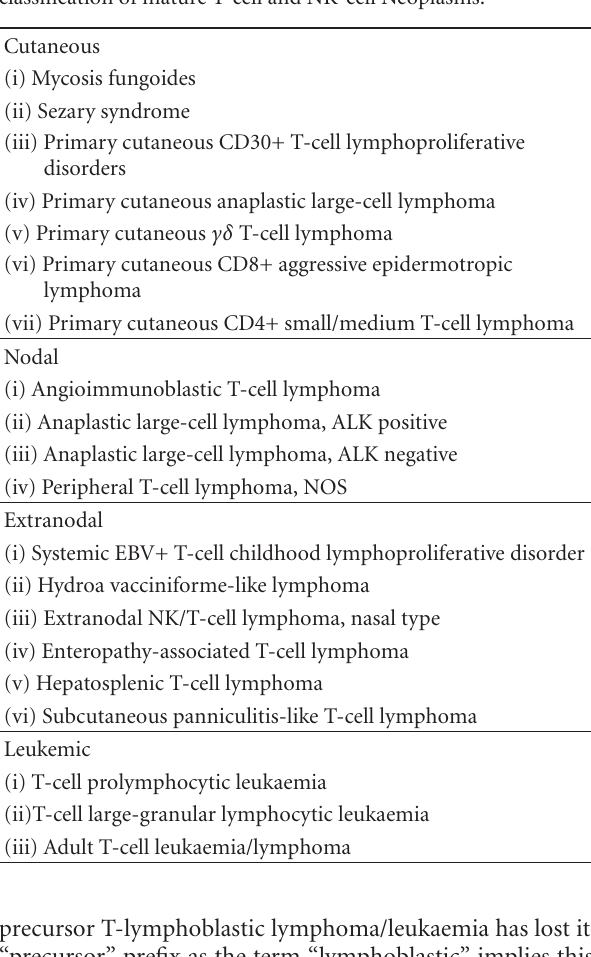
Table 1: List of T-cell lymphomas adapted from the 2008 WHO classification of mature T-cell and NK-cell